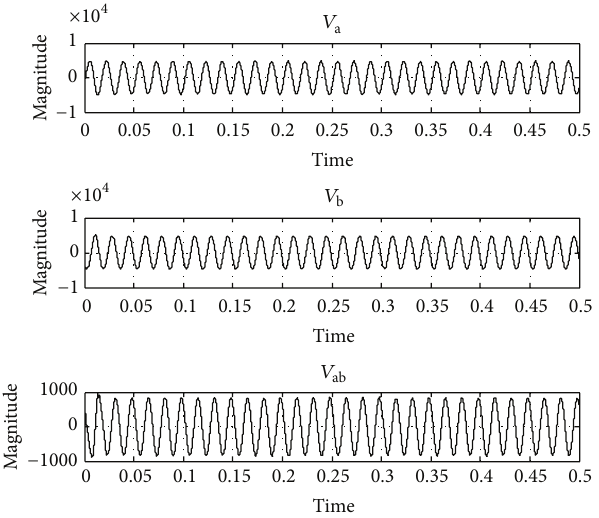
Figure 7: Output waveform without UPQC connected to the system. Table 2: Voltage sag mitigation performance.